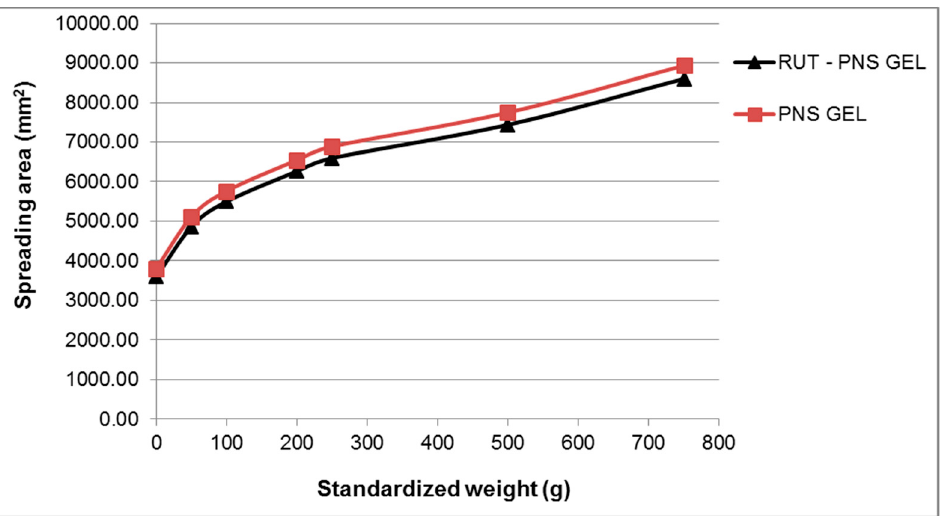
Figure 4. Extensiometric curves of experimental proniosomal gel containing 0.3% rutin and control formulation.